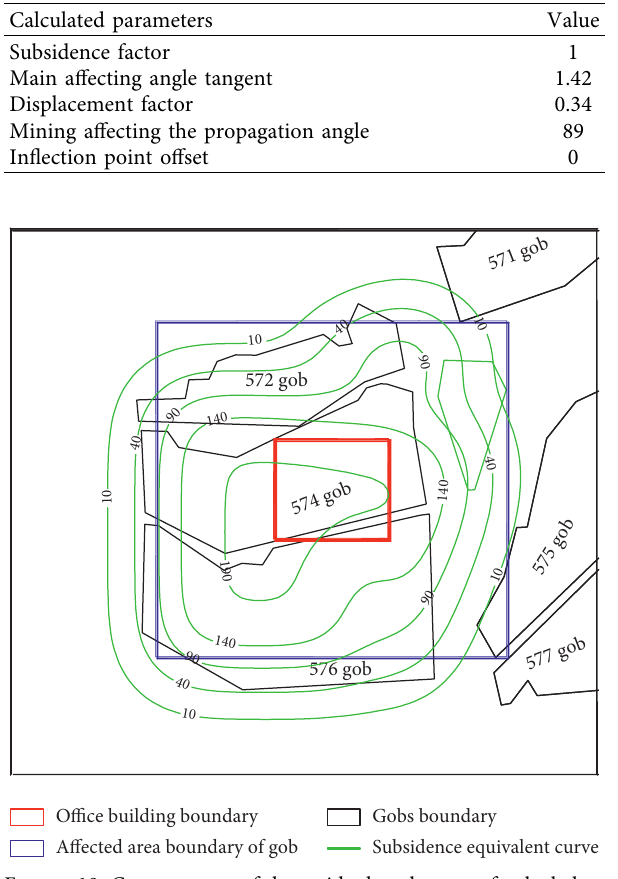
Figure 19: Contour map of the residual settlement of gobs below the office building (unit mm).